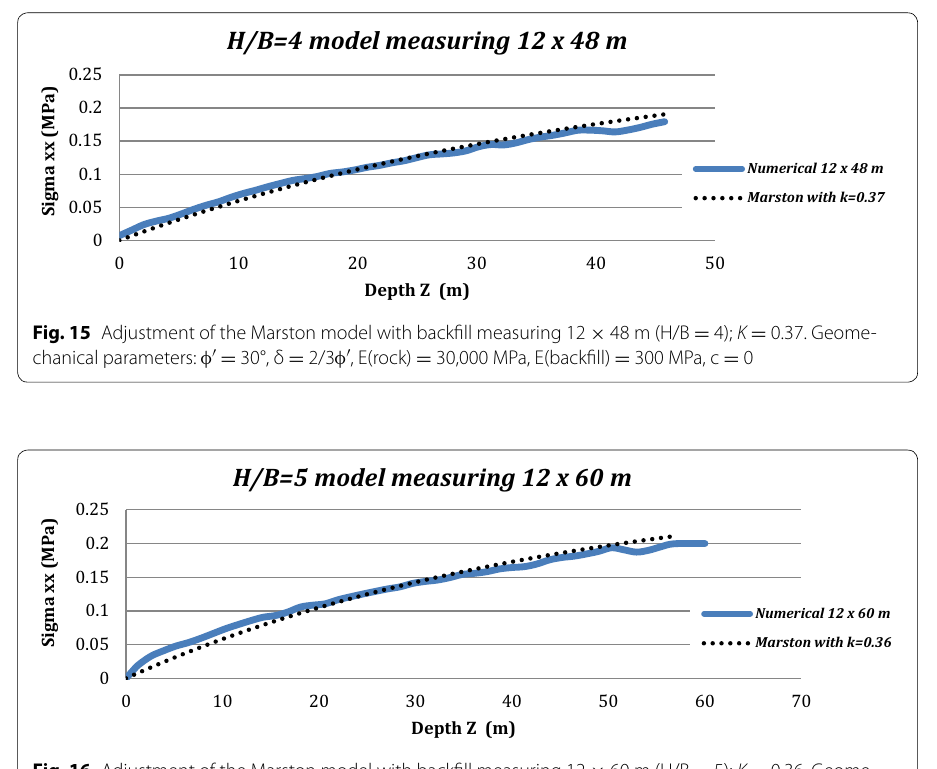
60 m (H/B 5); K 0.36. Geome- × = = 300 MPa, c = =